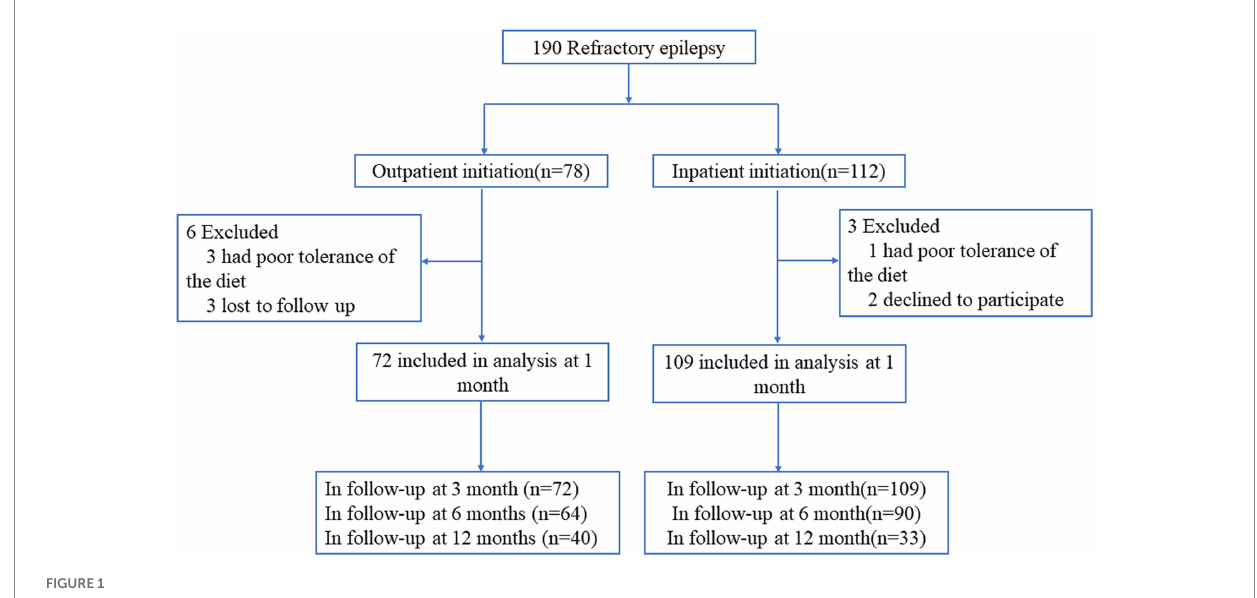
FIGURE 1 Detail of participants’